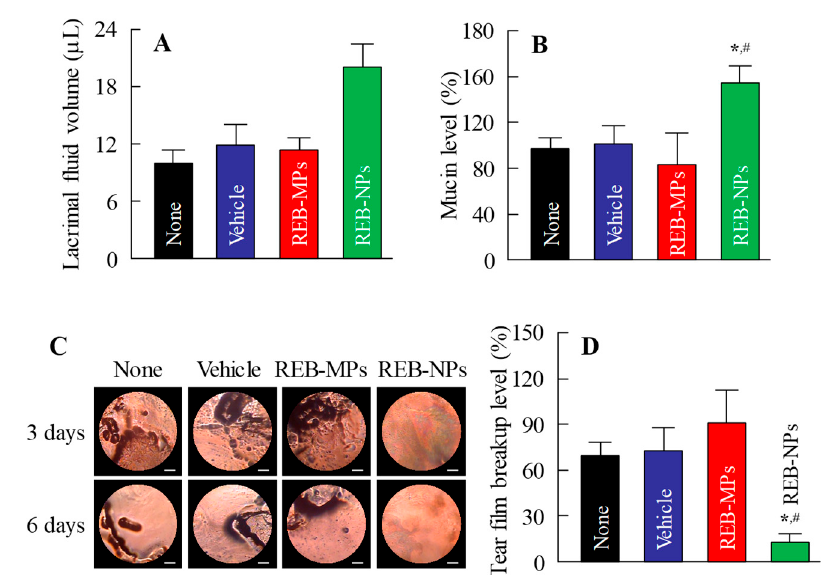
Figure 6. Therapeutic effect of the repetitive application of REB-NPs on dry eye in the N -acetylcysteine-treated rabbit model (dry eye model). Effect of REB-NPs on (A) the lacrimal fluid volume and (B) mucin levels in the dry eye model. (C) Images of the ocular surface in the dry eye model after repetitive applications of REB-NPs. The bar indicates 1 mm. (D) Effect of REB-NPs on tear film breakup levels in the dry eye model. Rabbits were treated repetitively with REB formulations at 14:00, and the experiments were performed at 18:00. n = 5–8. * P < 0.05, vs. none for each group. # P < 0.05, vs. Vehicle for each group. In the dry eye model, the application of REB-NPs enhanced the lacrimal fluid volume, and normalized the decreased mucin levels. In addition, the tear film breakup levels decreased by the application of REB-NPs.